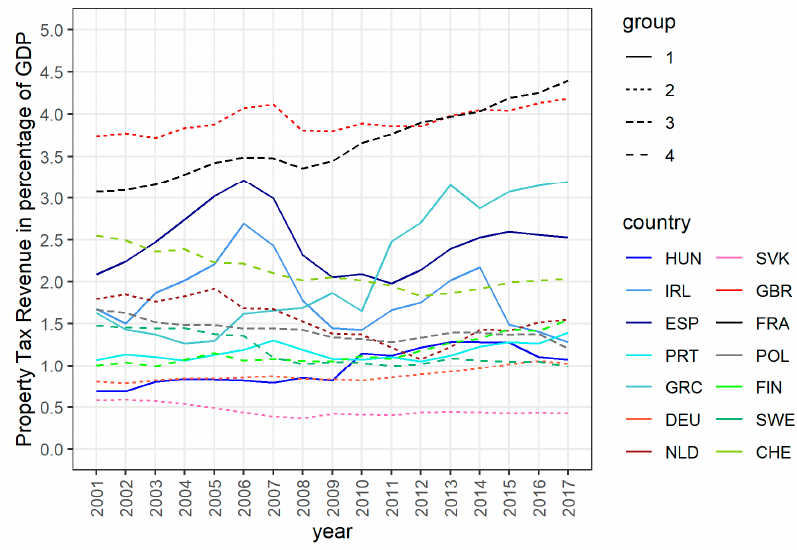
Figure 8. The development of property tax revenues in analyzed countries.